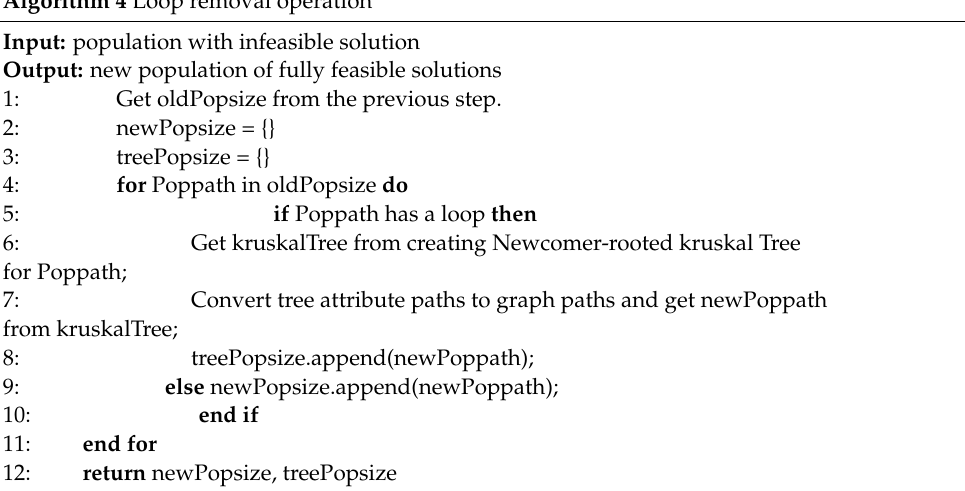
Algorithm 4 Loop removal operation